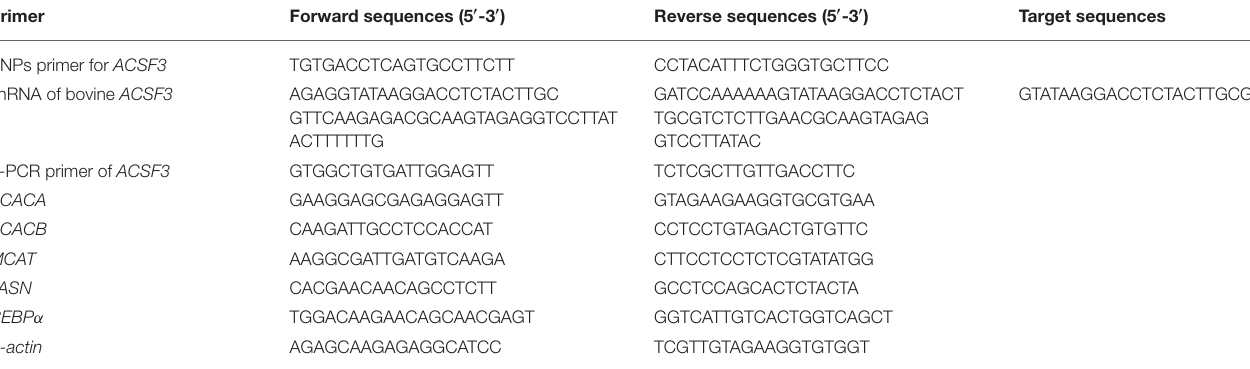
TABLE 1 | The primer sequences. Primer Forward sequences (5 ′ -3 ′ ) Reverse sequences (5 ′ -3 ′ ) Target